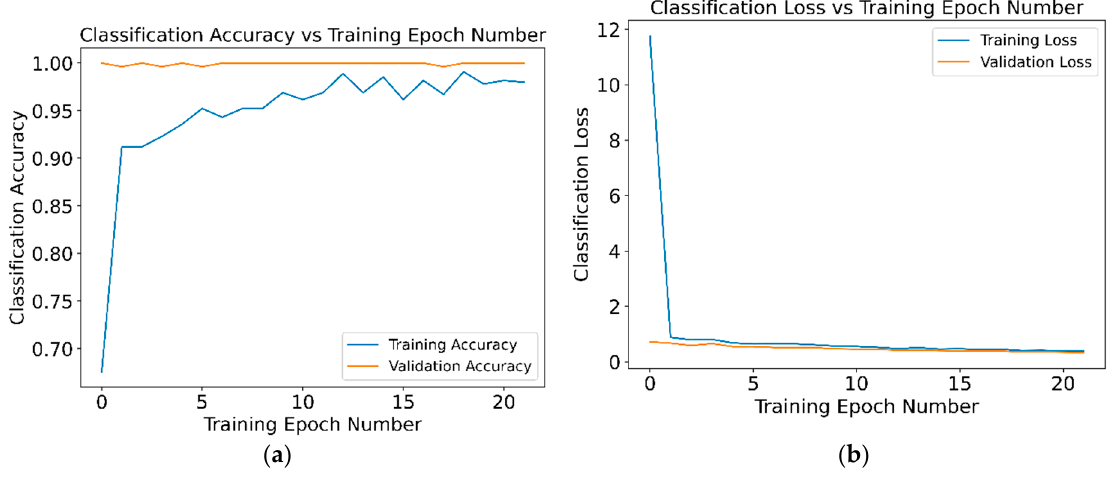
Figure 14. Dimmer Training Epoch Number: ( a ) Classification Accuracy, ( b ) Classification Loss.